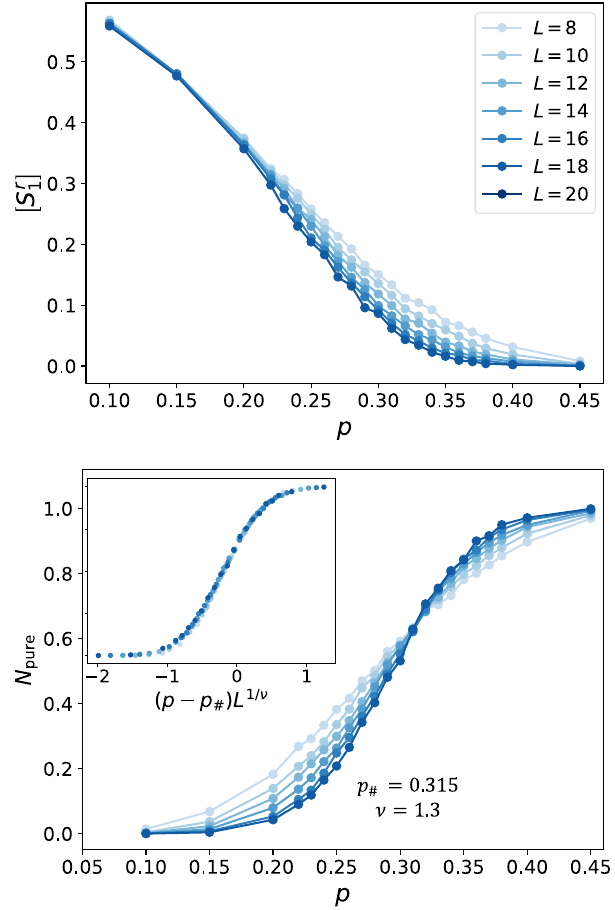
FIG. 9. Ancilla probe in the statistical mechanics model. Top: entanglement entropy of the ancilla qubit, which behaves as an order parameter for the charge-sharpening transition. Bottom: finite size scaling of the number of trajectories where the ancilla qubit is purified N , probing the charge-sharpening pure transition.